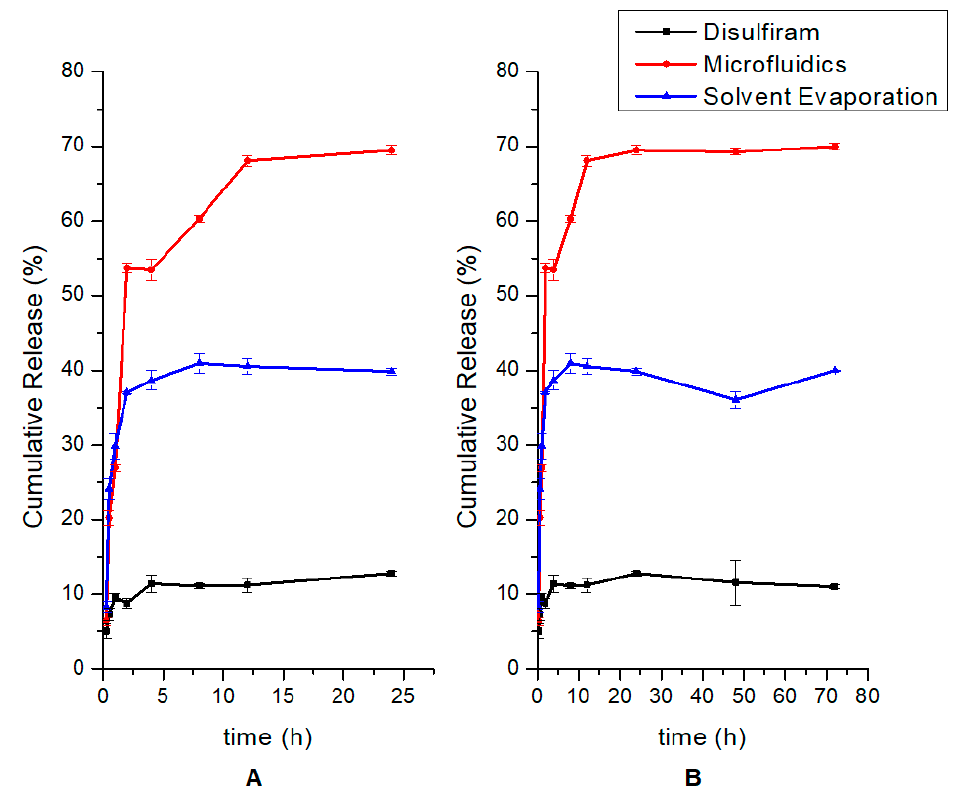
Figure 7. ( A ):24hand( B ):72hcumulativein vitroreleaseprofilesofnativedisulfiram,emulsificationsolvent Figure 7. ( A ): 24 h and ( B ): 72 h cumulative in vitro release profiles of native disulfiram, emulsification evaporation and microfluidic solvent evaporation and microfluidic nanoparticles.